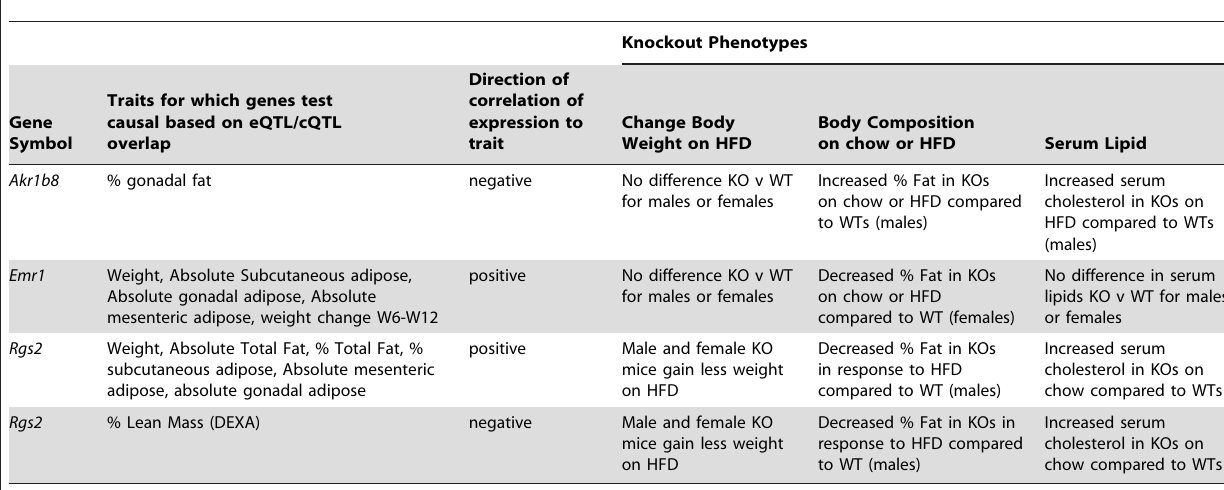
Table 3. Summary of Causality and Knockout Phenotype Data for Akr1b8, Emr1 , and Rgs2 .